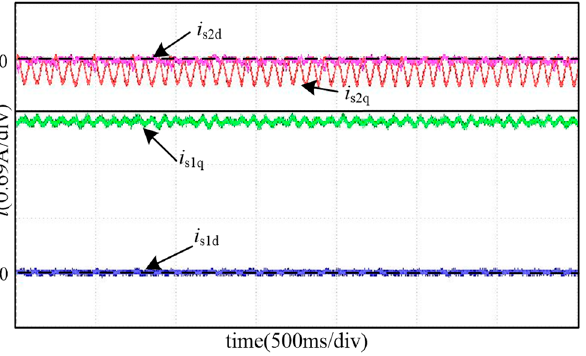
Figure 22. The decoupling current of dual − series FPMSMs decoupling control with current